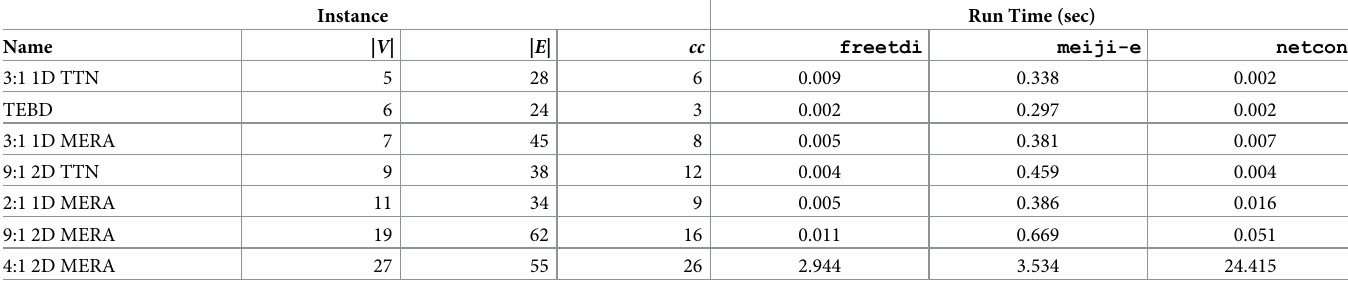
Table 1. Run times for each contraction sequence algorithm when executed on tensor network datasets from Pfeifer et al. [22]. For each tensor network, the number of tensors (| V |), edges (| E |), and optimal contraction complexity ( cc ) are